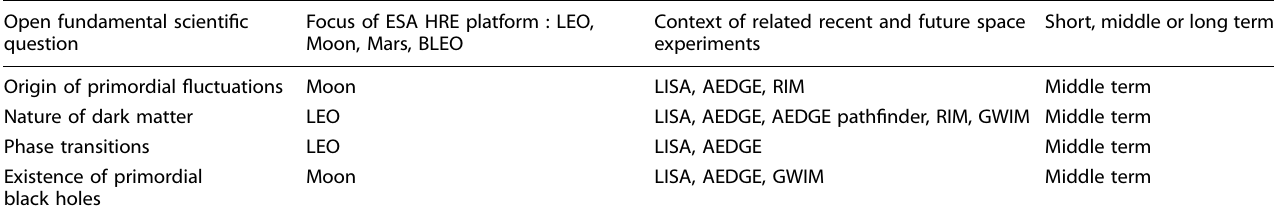
Table 1. Recommendations for addressing key questions in fundamental cosmology with the ESA HRE programme in the short, middle and long